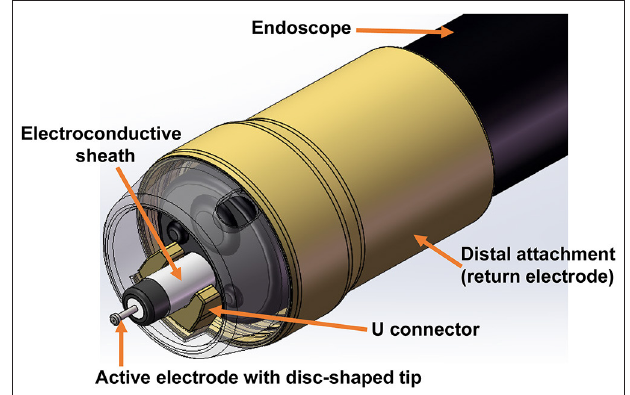
FIGURE 1 | The structure of the novel bipolar